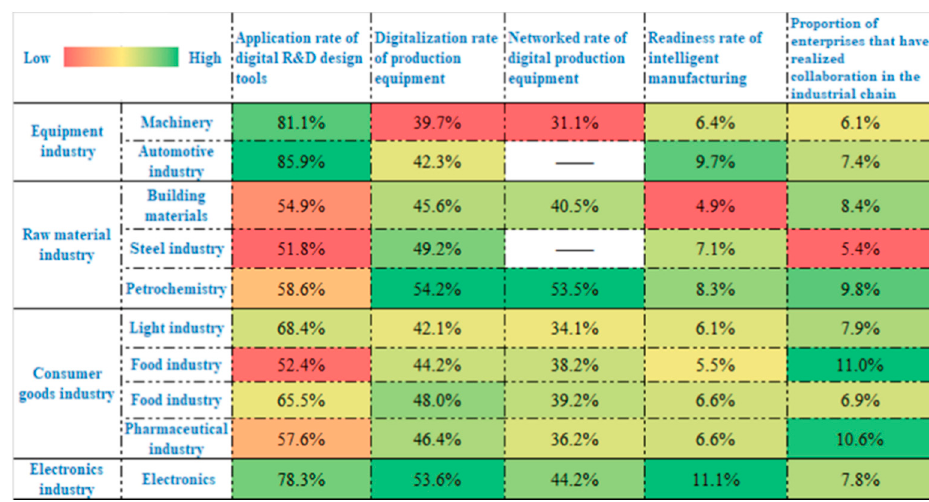
Figure 12. Key indexes of digital transformation of China’s major sectors.